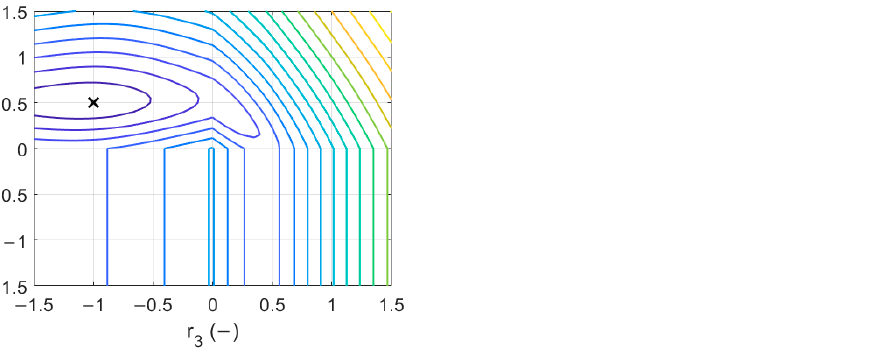
Figure 12. Error function in the sought parameters ( r 3 and r 4 ) space. The location of the optimal value is marked with ‘x’.